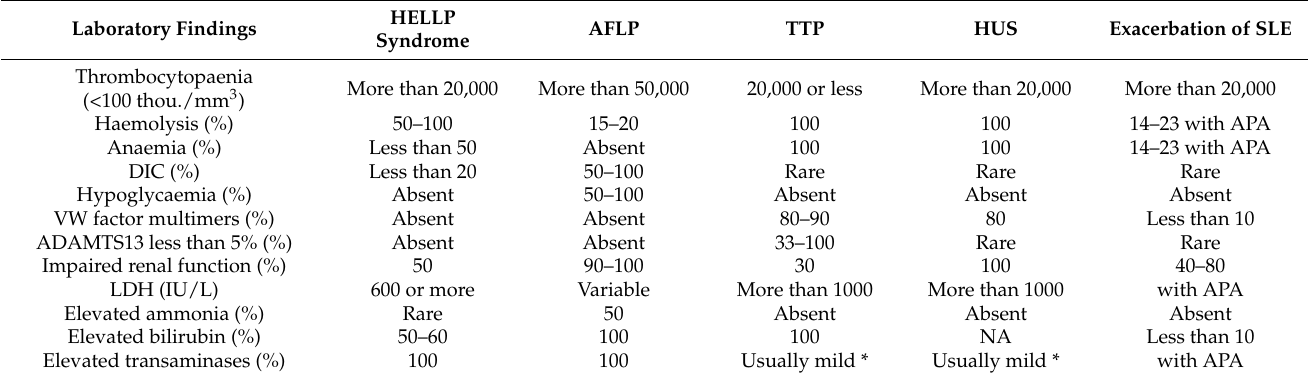
Table 4. Laboratory findings typical for pregnancy complications in which DIC may occur